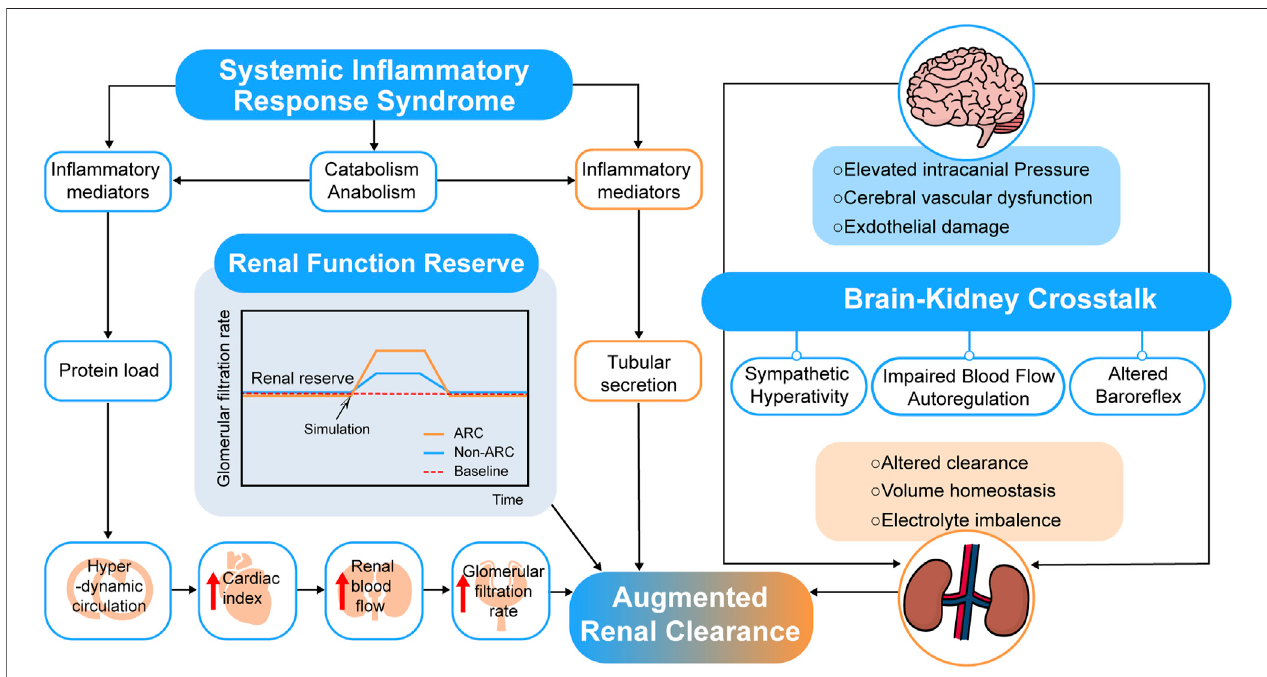
FIGURE 2 | Overview of probable mechanisms of augmented renal